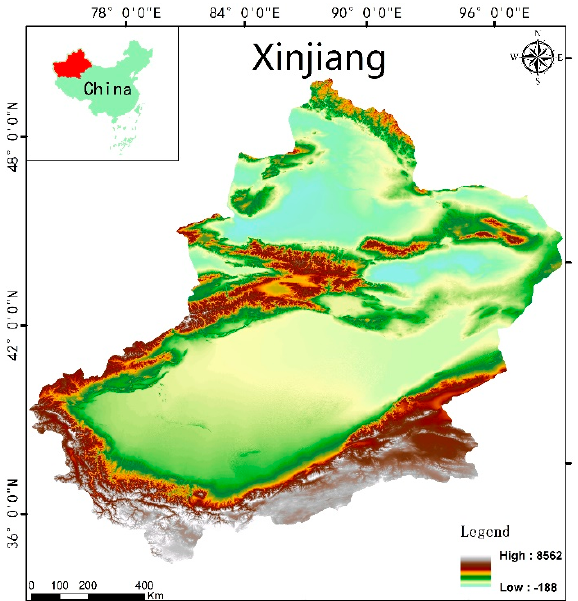
Figure 1. Location map and overview of the study area of Xinjiang (based on map sources: Depart- ment of Natural Resources of Xinjiang Uygur Autonomous Regions Xin S (2019) No. 044).